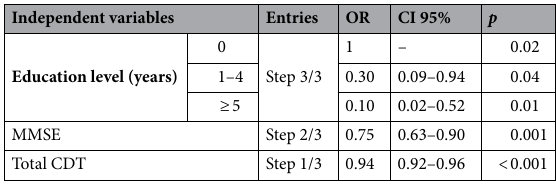
Table 3. Independent variables in the new binary I model.